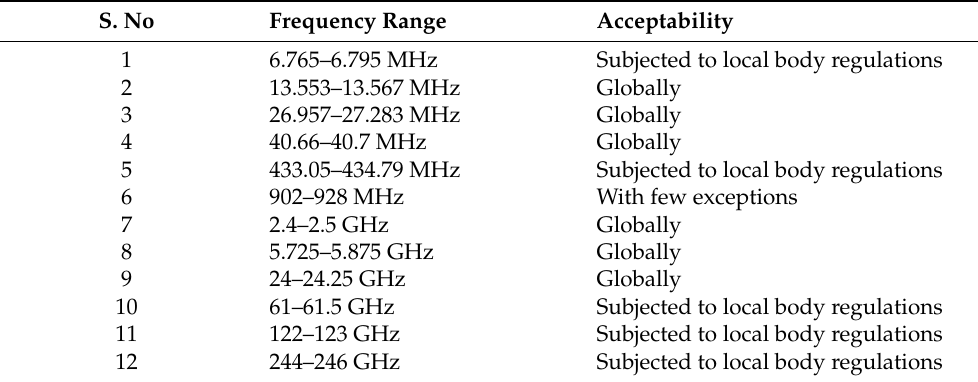
Table 7. Various industrial, scientific and medical bands.